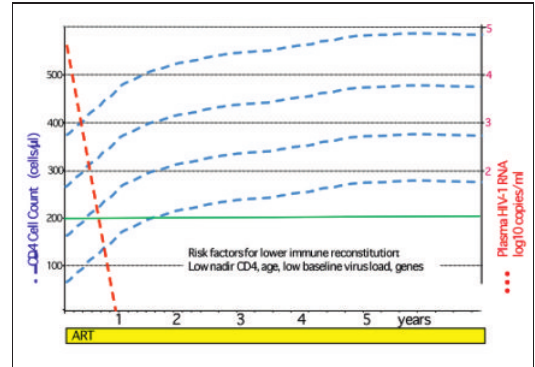
Combination antiretroviral therapy